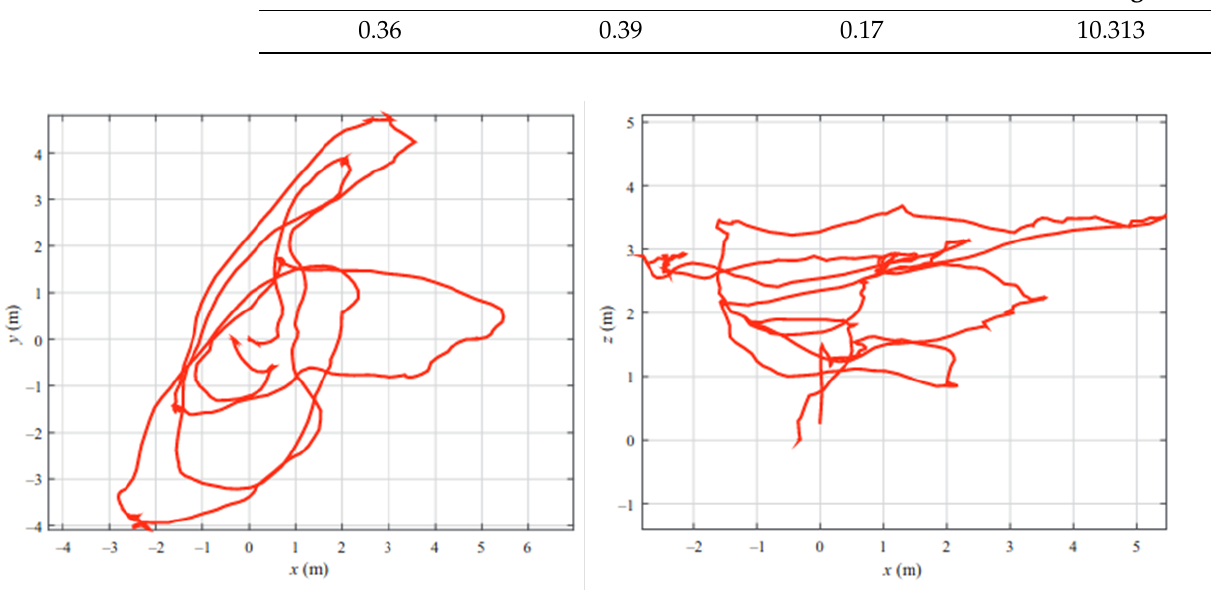
Figure 11. Flight of